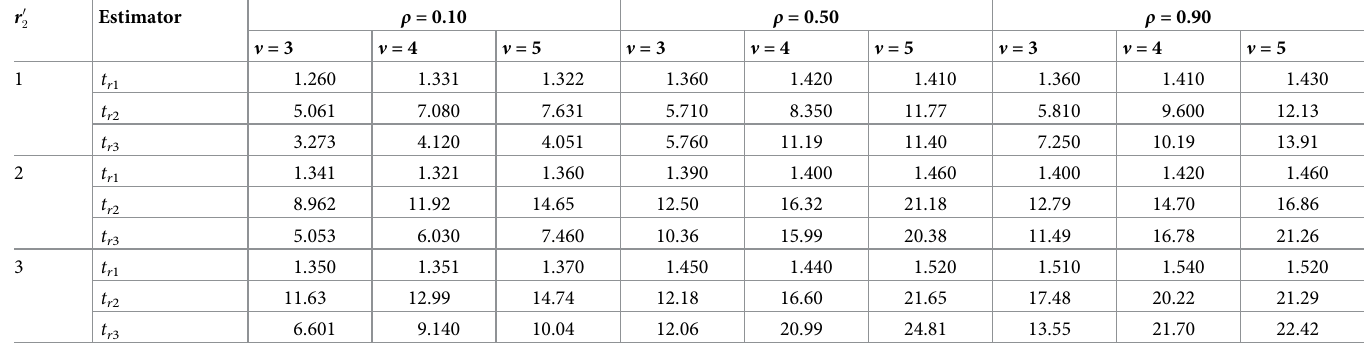
Table 2. RE of proposed class of estimators for Situation-I when k = 3. Estimator r 0 2